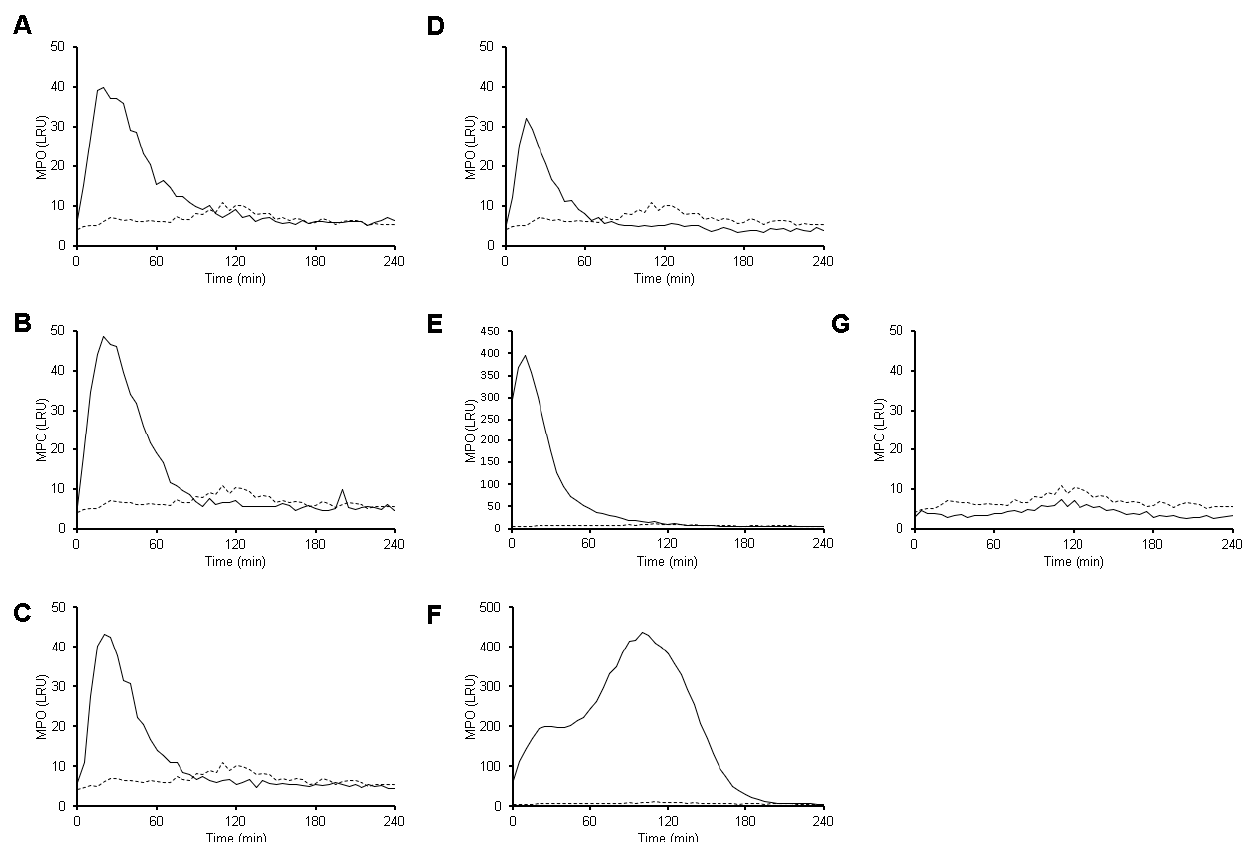
Figure 6. MPO activity is detected during interaction between neutrophils with E. histolytica . Neutrophils (1 × 10 5 ) were culture in RPMI-1640 medium supplemented with 5%FBS and luminol (200 µ M). Cells were stimulated with viable E. histolytica trophozoites at ratios of 1:100 ( A ), 1:50 ( B ), 1:20 ( C ) and 1:10 ( D ), as well as 50 nM PMA ( E ), 10 µ M A23187 ( F ). Amoebas alone (1 × 10 4 ) also were tested ( G ). Black line represents MPO activity (as luminescence relative units, LRU) after stimulation and dotted line represents MPO activity on neutrophils in the absence of stimuli (same for all plots). Values are means of three independent experiments.